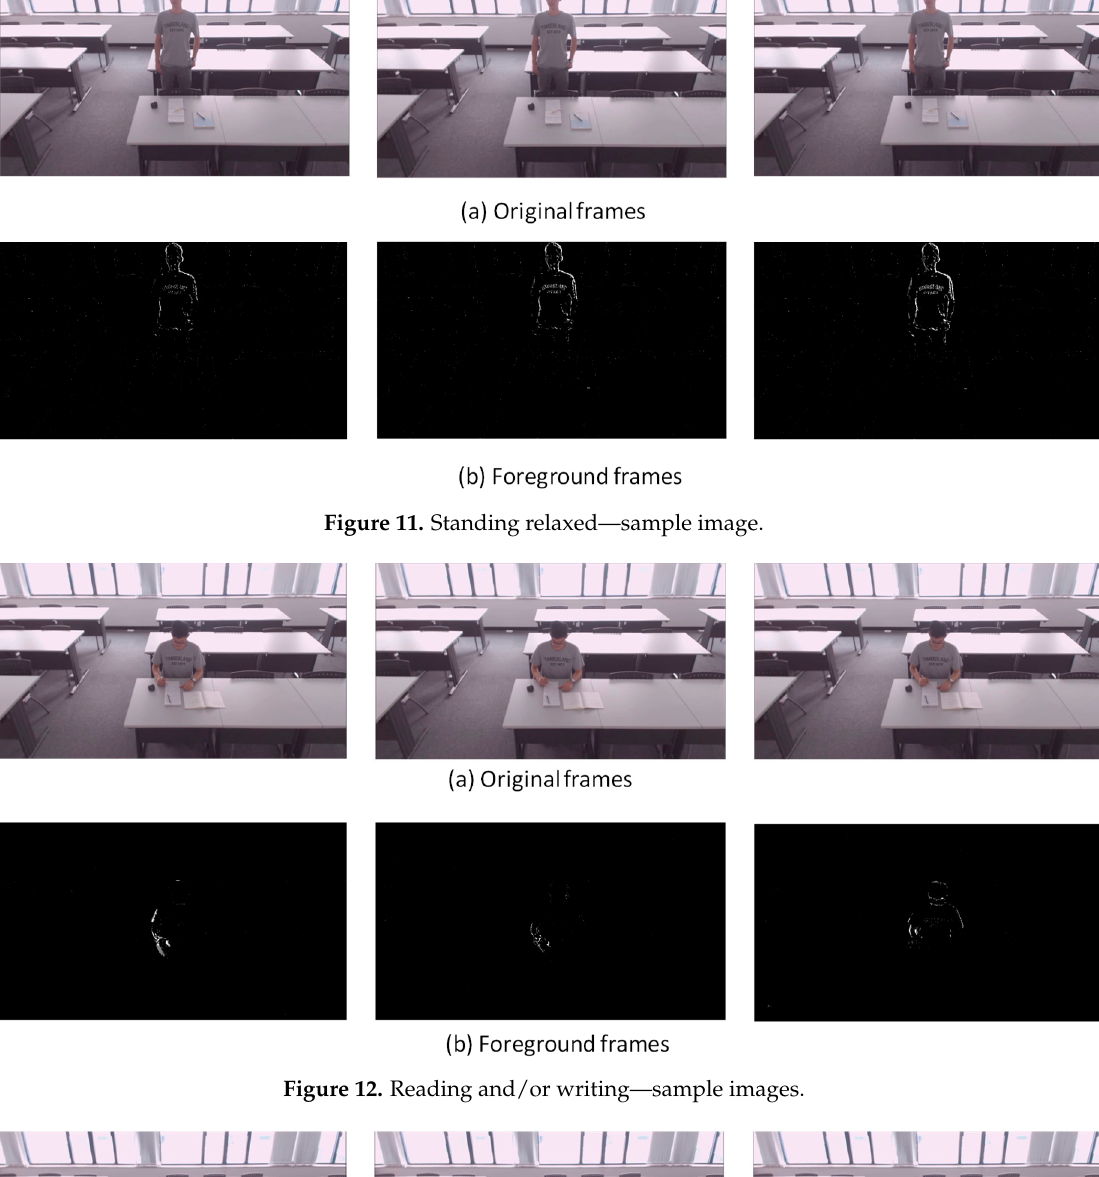
Figure 12. Reading and/or writing—sample images.